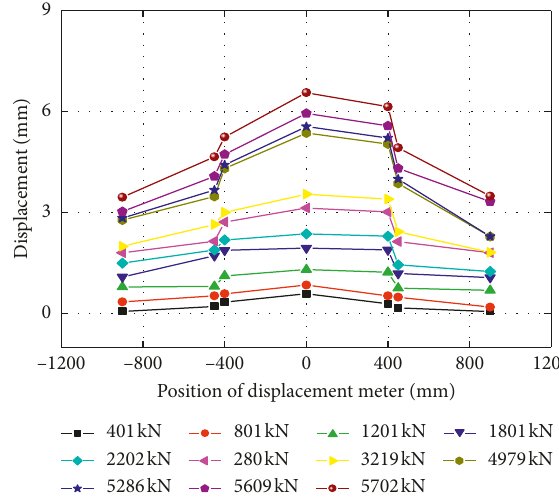
Figure 12: The deformation of J-1. Figure 13: The deformation of